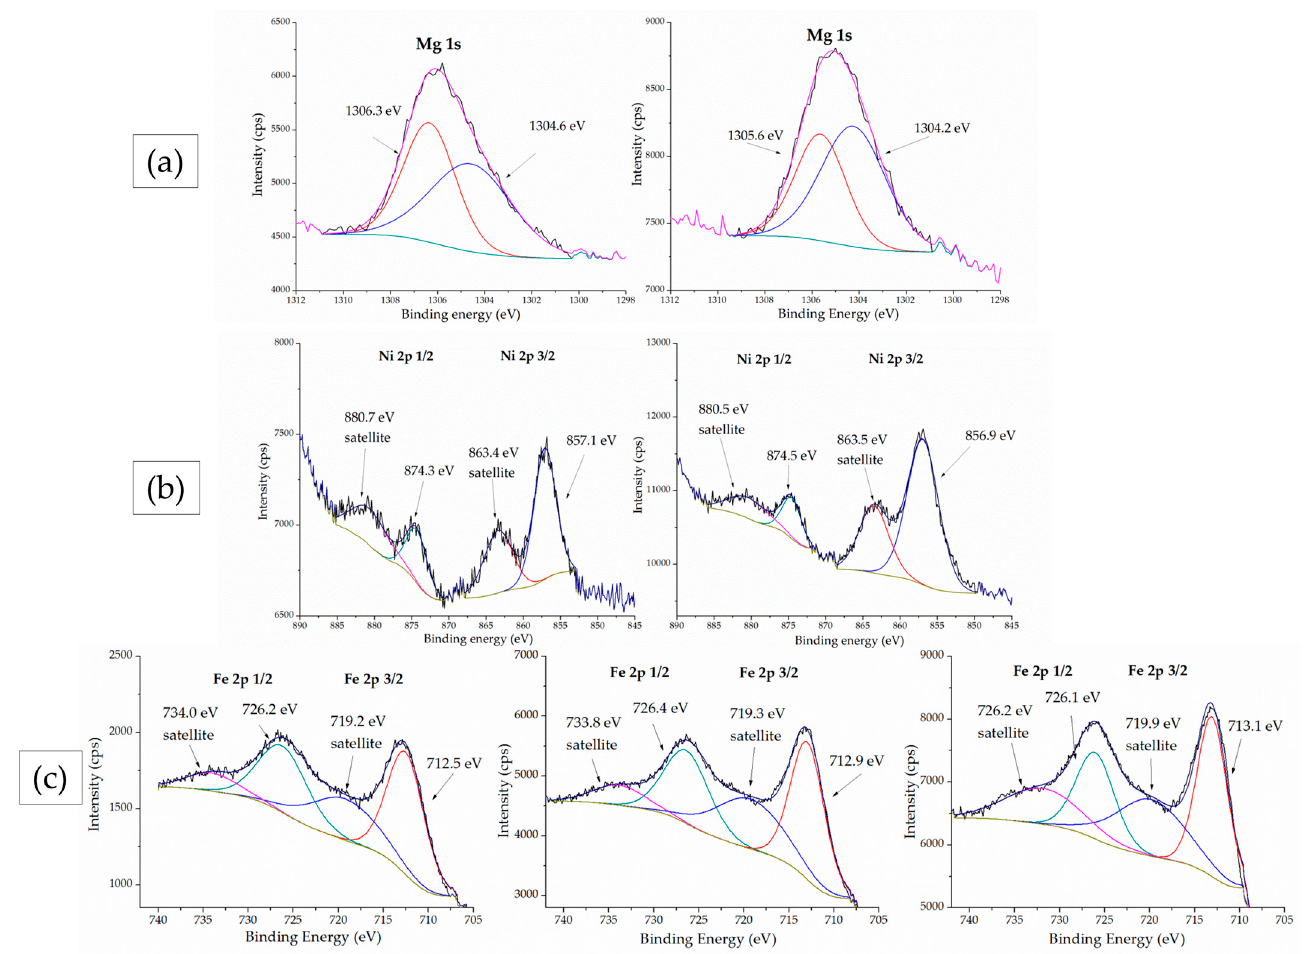
Figure 7. XPS spectra of: ( a ) Mg 1s, ( b ) Ni 2p and ( c ) Fe 2p peaks for the materials MgFe 2 O 4, Ni 0.5 Mg 0.5 Fe 2 O 4 and NiFe 2 O 4, from top to bottom.